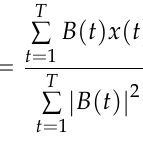
Figure 3. NN architecture for DOA estimation.